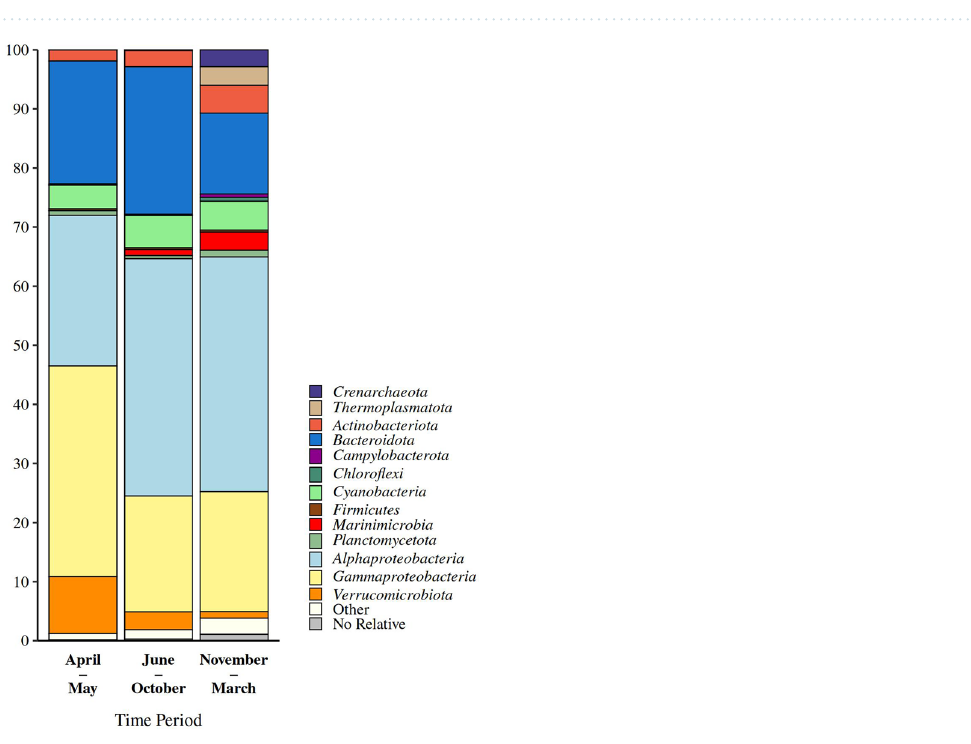
Figure 2. Taxonomic classification and relative contribution of the most abundant (≥ 1 %) bacterial and archaeal sequences during different time periods. No Relative – sequences without known